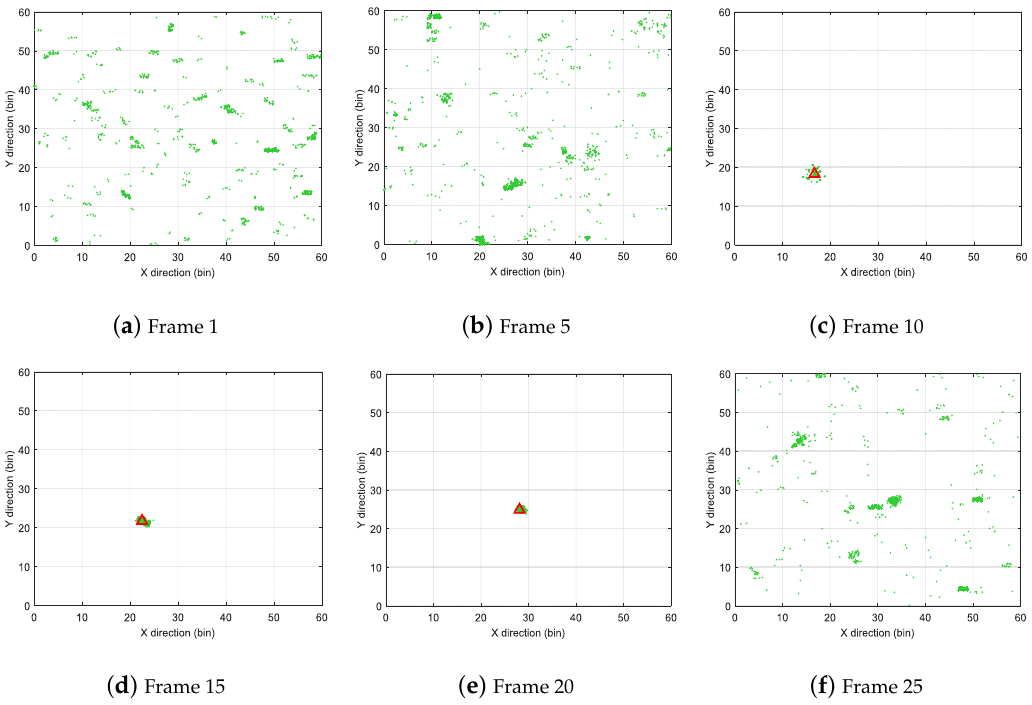
Figure 5. Distribution of particles corresponding with frames in Figure 4.